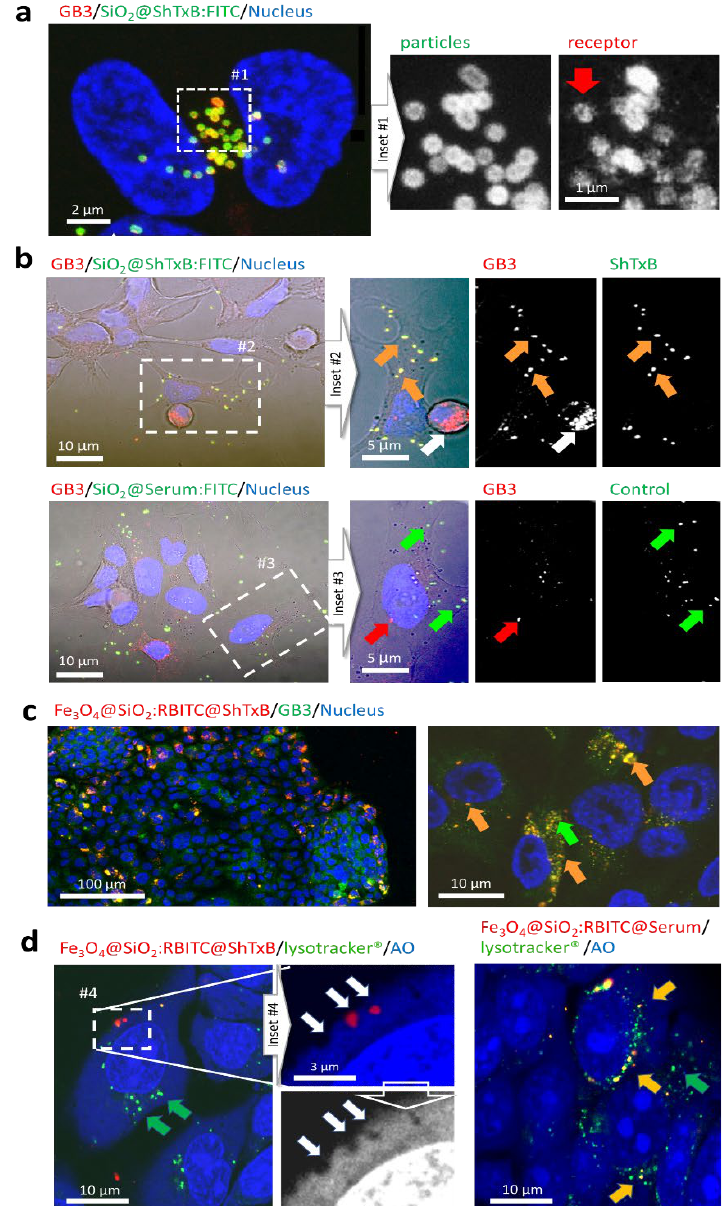
Figure 3. Targeting of ShTxB-coated particles to live HNC cells. ( a ) Live human HNC cells exposed to SiO 2 @ShTxB:FITC particles (green channel). The clustering of GB3 receptors (inset #1, red arrow) is observed. ( b ) Phase-contrast/fluorescent confocal microscopy images of cells exposed to particles functionalized with ShTxB or serum for 1 h. All ShTxB-particles colocalize with GB3 receptors (inset #2, orange arrows). A rounded cell, undergoing cell division (inset #2, white arrow), displays no surface GB3 receptors and serves as a negative control. (inset #3, green arrows) Serum-coated particles are randomly distributed in the extracellular and intracellular spaces. (orange arrows). ( c ) Colocalization of Fe 3 O 4 @SiO 2 :RBITC@ShTxB nanoparticles and GB3 receptors. ( d ) Confocal single Z plane images of ShTxB-coated and control serum-coated nanoparticles on cells stained with acridine orange (AO, blue channel) a lysosomal marker (lysotracked ® , green channel). Clusters of ShTxB- nanoparticles are trapped in membrane folds during cell entry (red channel, white arrows) and do not colocalize with the lysosomes (labeled in green, green arrows). On the contrary, serum-coated nanoparticles colocalized with lysosomes (orange arrows). Green arrows point at empty